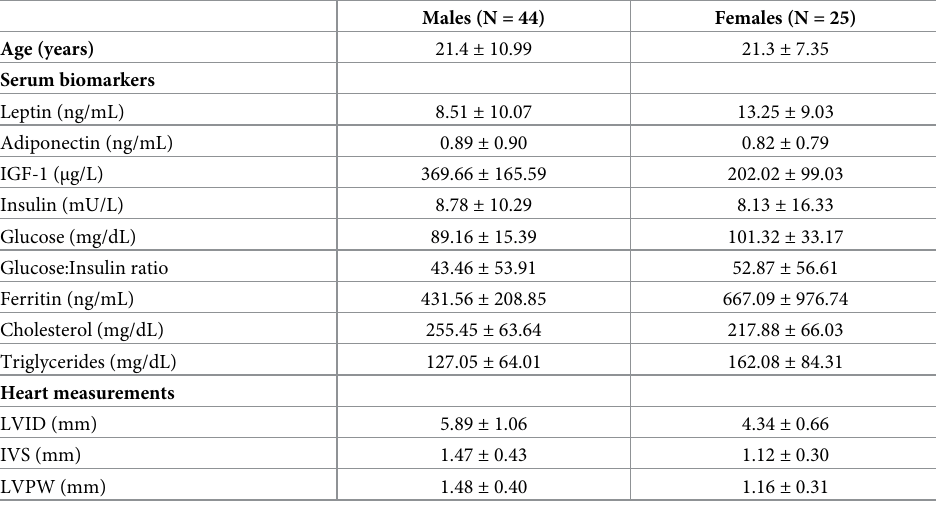
Table 1. Summary data for serum biomarkers and heart measures.